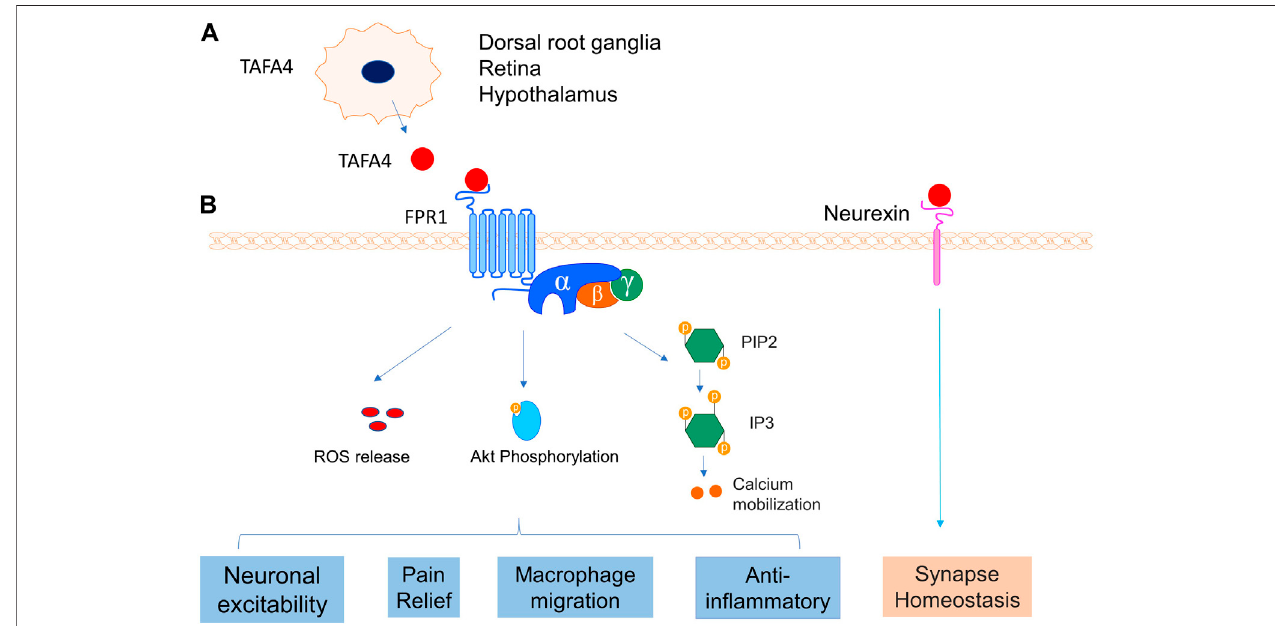
FIGURE 11 | TAFA4 and its receptors interaction. (A) TAFA4is expressed in DRG, retina and hypothalamus. (B) TAFA4 binds FPR1 and activates signalling pathways of Akt phosphorylation, calcium mobilization, and ROS release, leading to various cellular activities. In addition, TAFA4 binds cell surface neurexin and mediates synapse homeostasis.